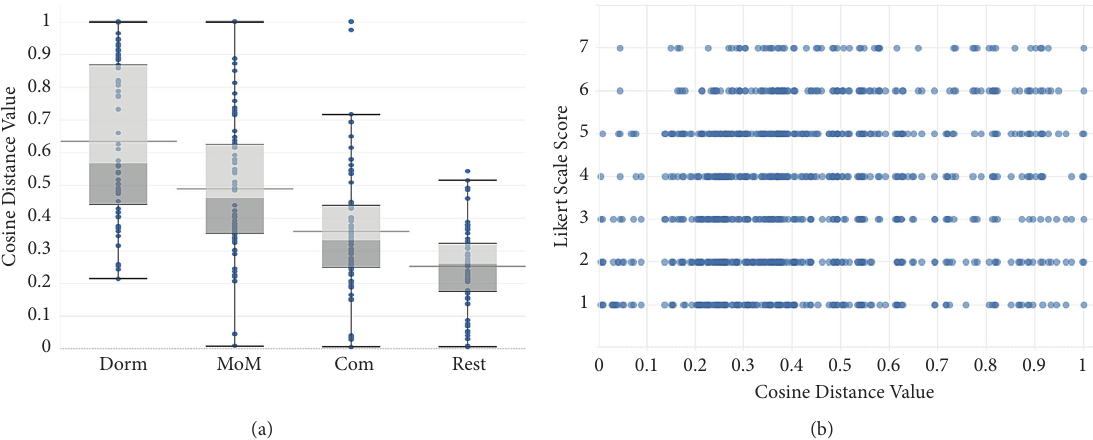
Figure 5: (a) Distribution of cosine distance values of the evaluated recommendations from each structural network position. The lower the cosine distance value, the higher is the similarity; (b) the values of respondents’ scores and cosine distances scattered relatively randomly and in similar fashion along the Likert scale (strongly agree (1)–strongly disagree (7)), which implies that there are no dependencies between the given scores and cosine